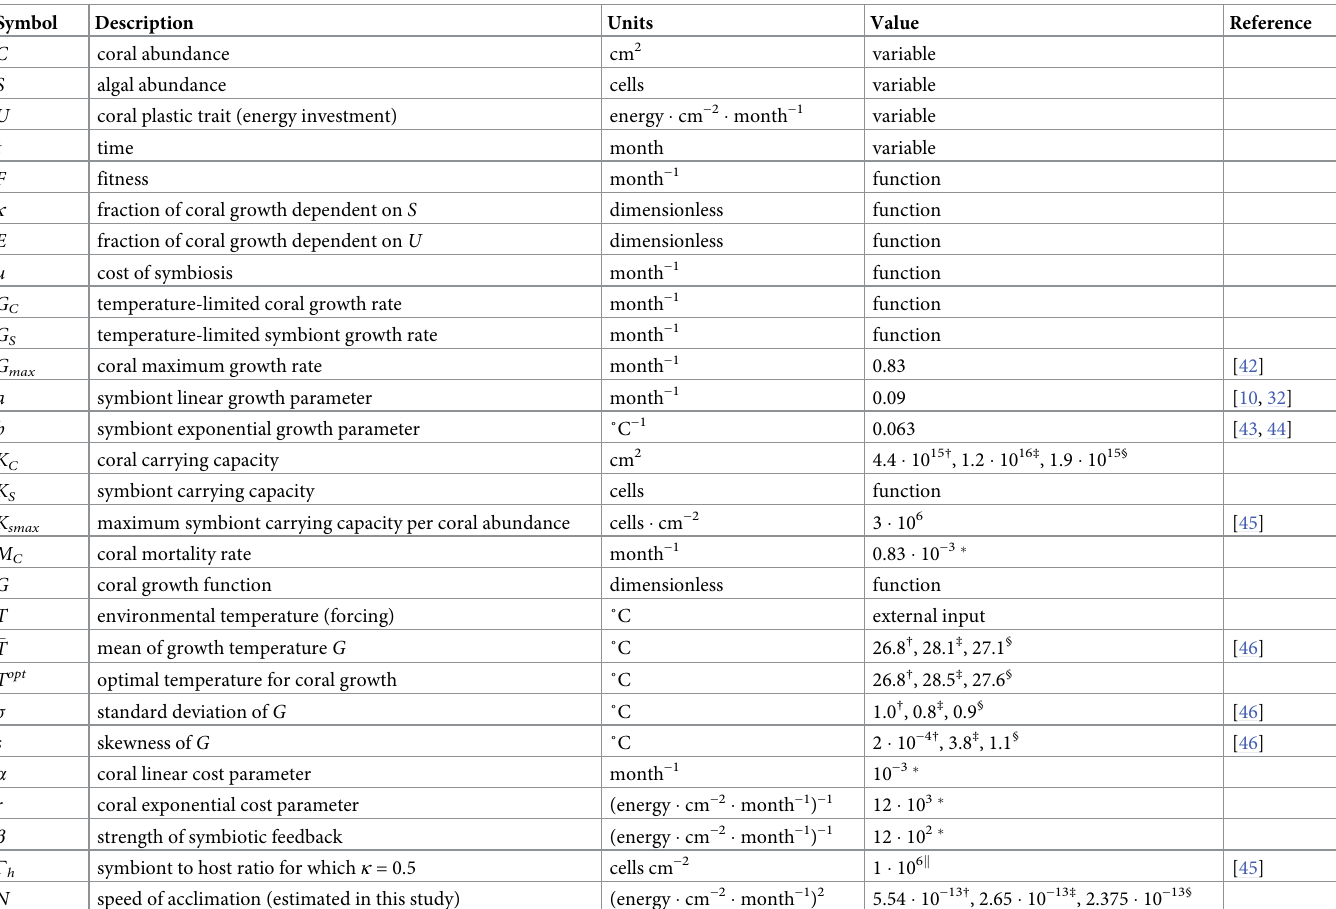
Table 1. State variables, functions, and parameters constituting our